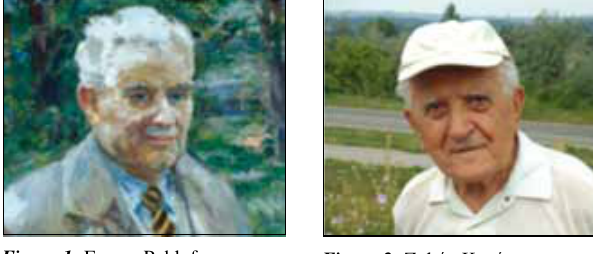
Figure 2: Zoltán Kováts, ornamental breeder of